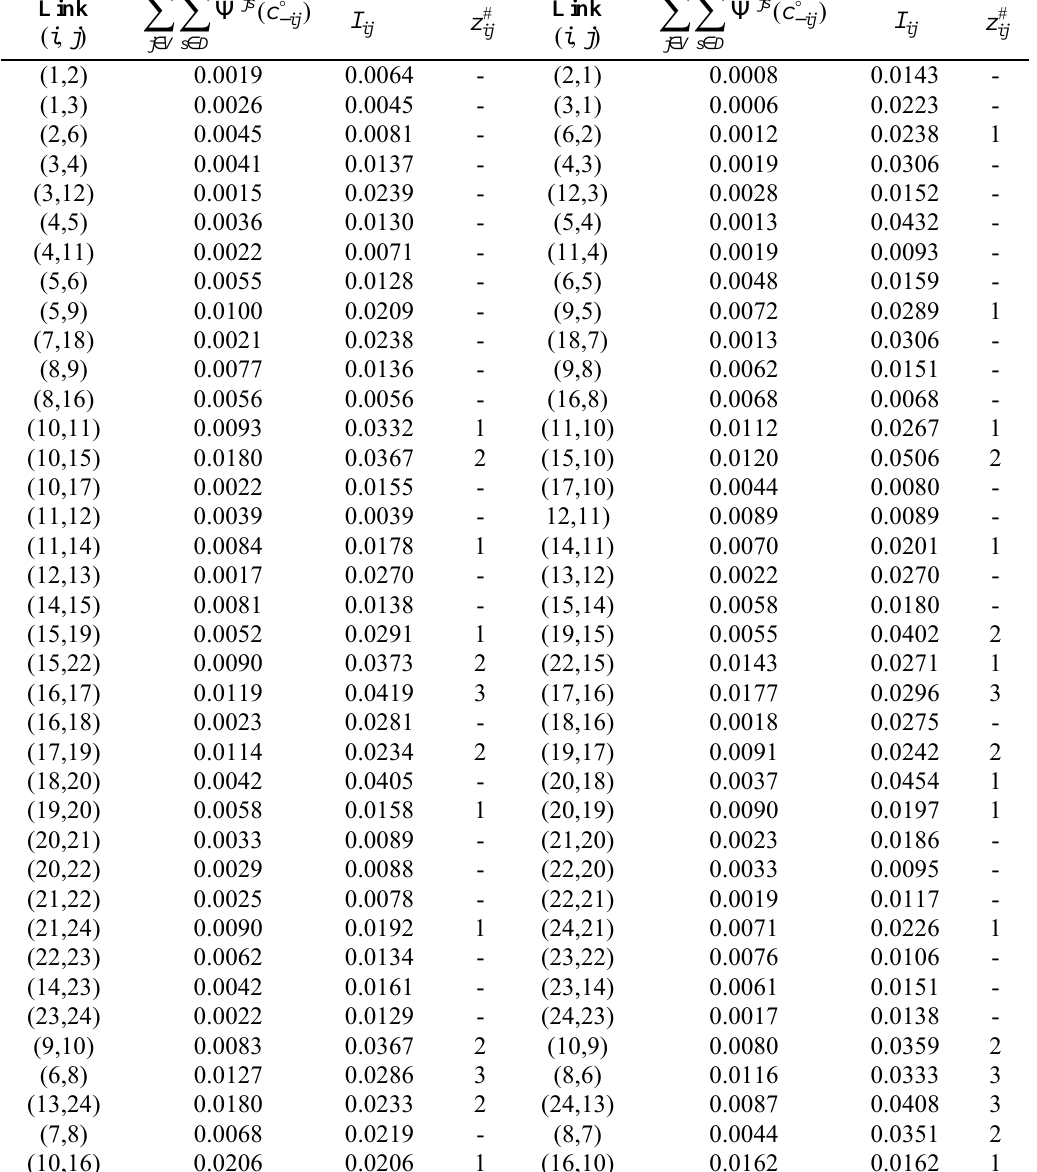
Table 6. Result of applying algorithm (AP) on Example Network